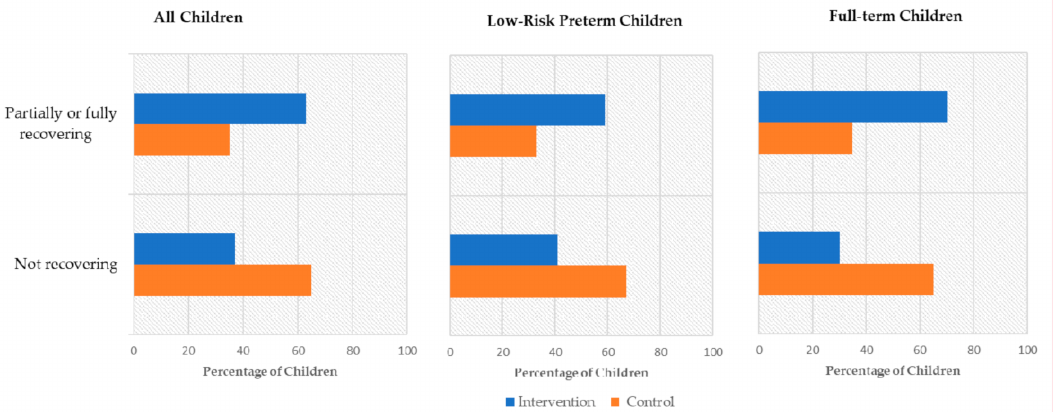
Figure 2. Percentage of children “partially or fully recovering” and “not recovering” expressive lexical delay from pre- to post-intervention assessment in the intervention and control group considering the whole sample and the low-risk preterm and full-term